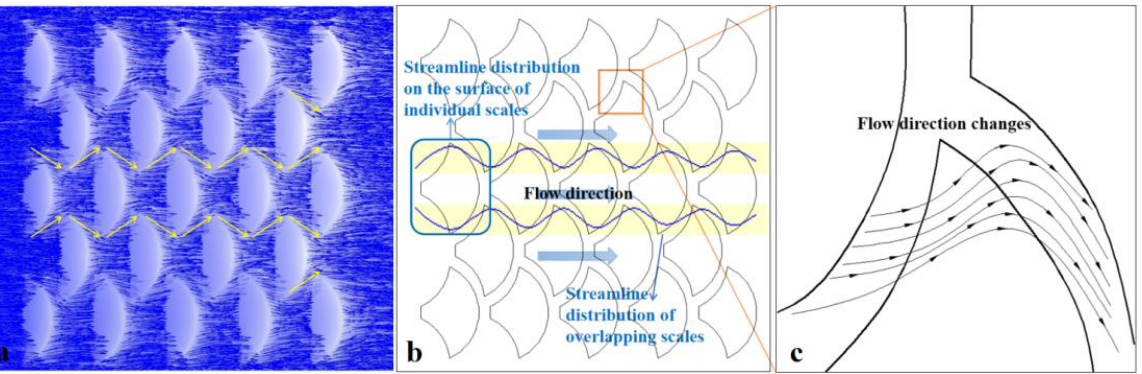
Figure 20. Wavy flow state diagram. ( a ) vVelocity vector diagram of the scale array region; ( b ) The “corrugated” streamlines; ( c ) The direction of streamlines changed between every two scales.